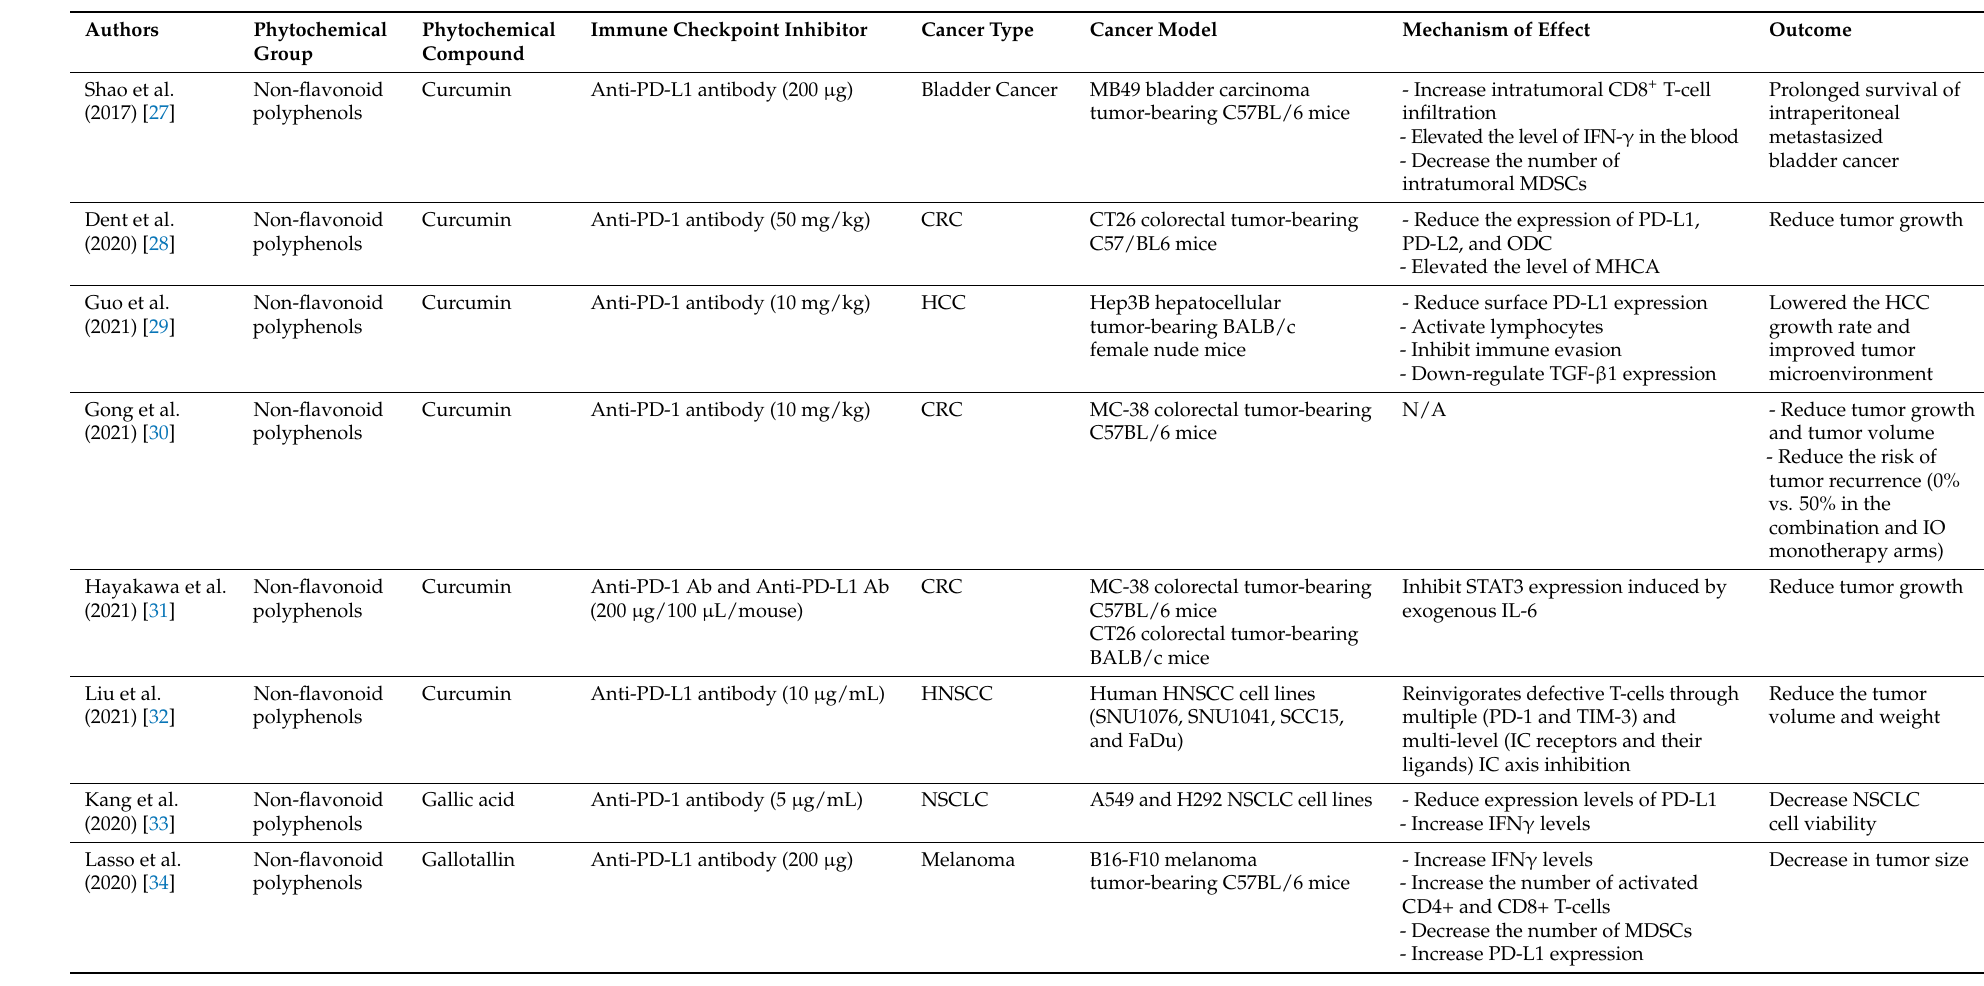
Table 1. The combined effect of dietary phytochemicals and immune checkpoint inhibitors on different types of